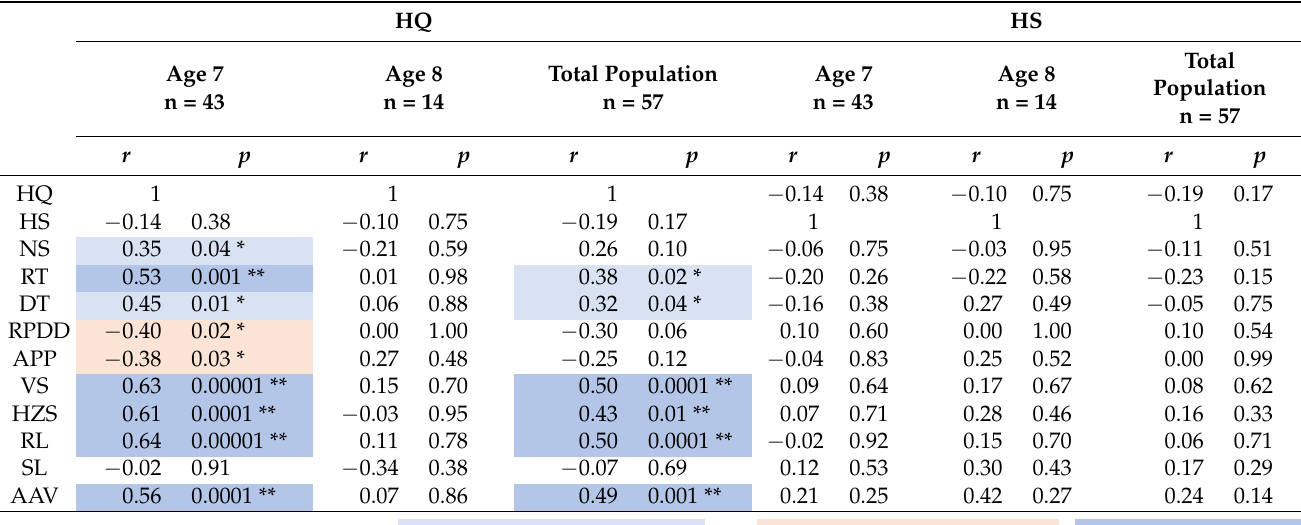
Table 2. Correlations between handwriting production and process characteristics for the 7-year-old and 8-year-old groups and the total